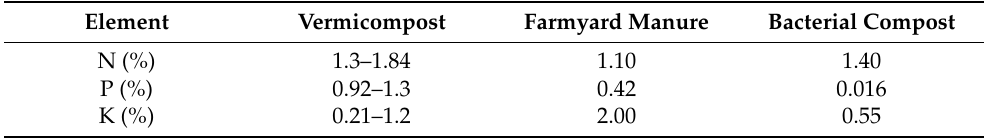
Table 2. Nitrogen (N), phosphorus (P), and potassium (K) content of different organic